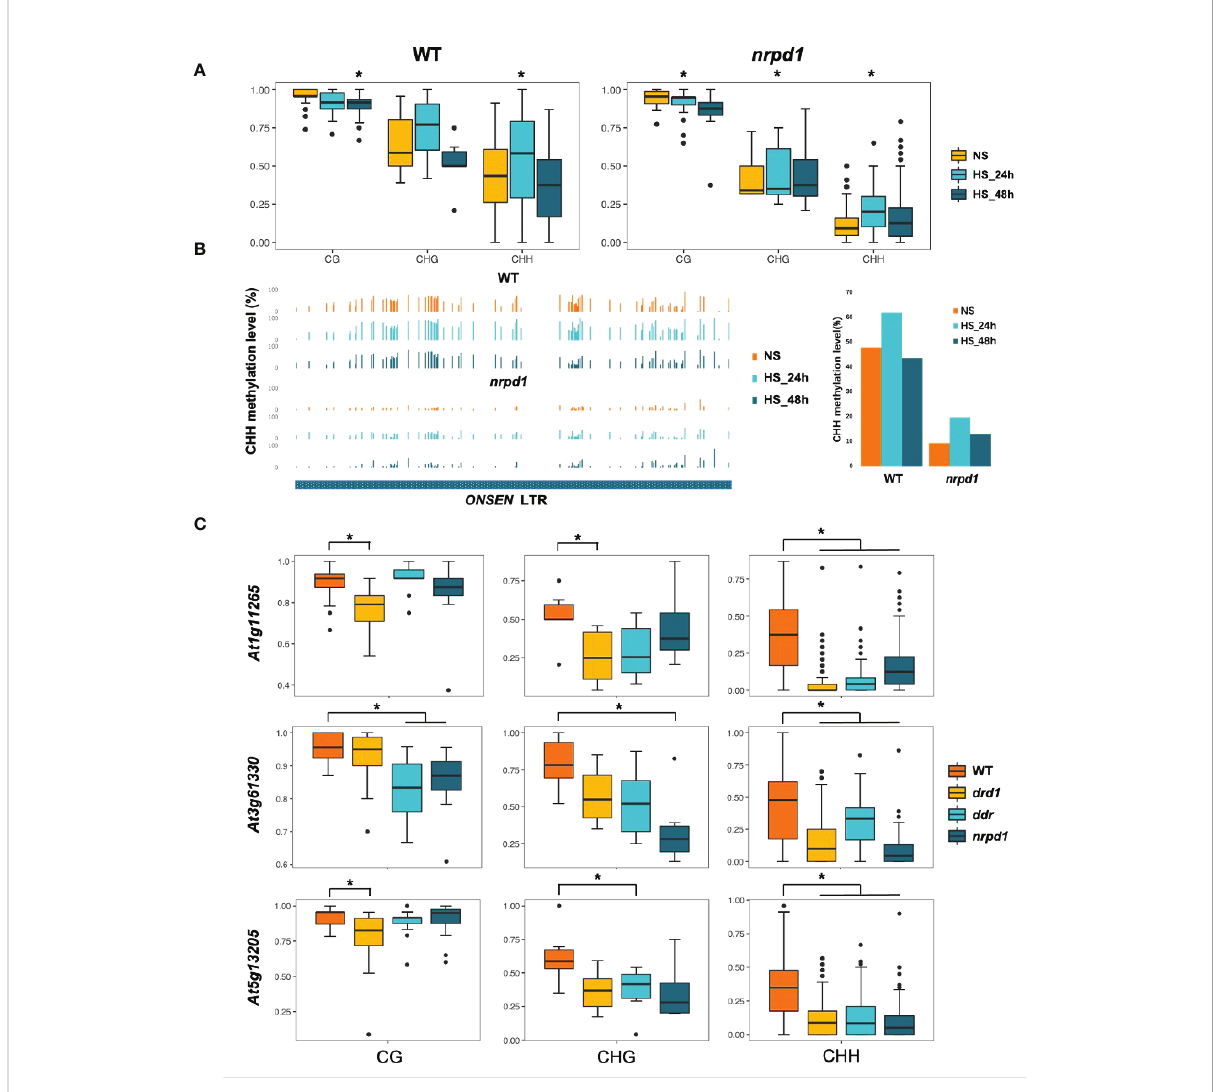
FIGURE 5 Relationship between duration of high-temperature treatment and ONSEN DNA methylation levels. (A) Boxplots show the CG, CHG, and CHH (H = A, T, C) methylation levels of ONSEN ( At1g11265 ) in wild type and nrpd1 mutant. Asterisks indicate signi fi cant differences compared to NS (Student ’ s t -test, P < 0.05). (B) CHH methylation levels of the LTR region of ONSEN ( At1g11265 ) in wild type and nrpd1 mutant under non-stress (NS) and heat-stress (24 and 48 h). (C) DNA methylation levels (CG, CHG, and CHH (H = A, T, C)) of ONSEN ( At1g11265 , At3g61330 , and At5g13205 ) in wild type and drd1 , ddr , and nrpd1 mutants after 48 h of heat stress. Asterisks indicate signi fi cant differences compared to WT (Student ’ s t -test, P <